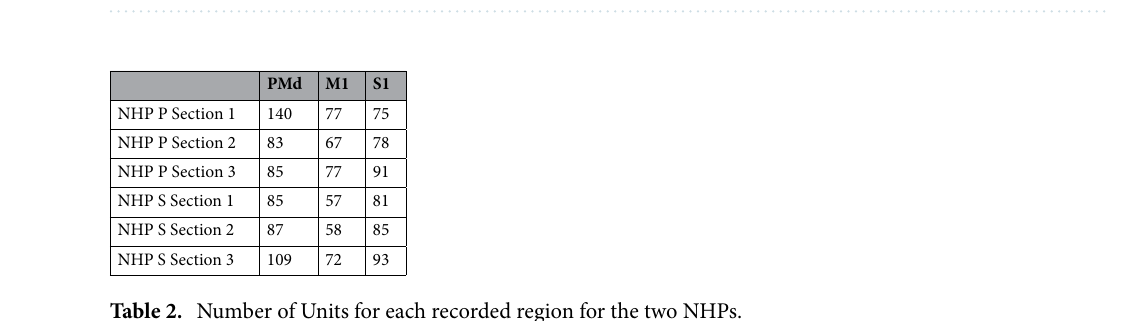
Table 1. Trial number for each cued reward (R) and timeout punishment (P) Level.